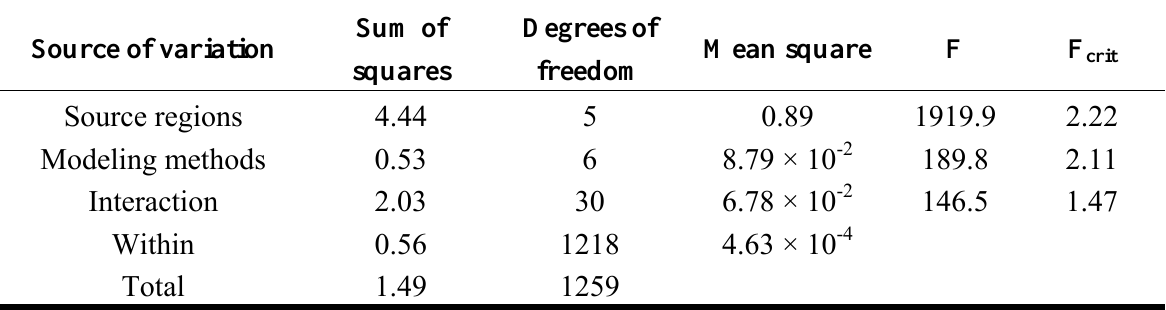
Table 7. ANOVA table of the Italian olive oil data set by different source regions and modeling methods. F is the critical crit